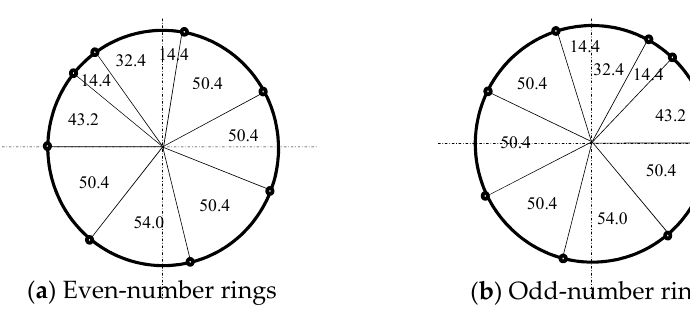
Figure 5. Staggered arrangement of segments.